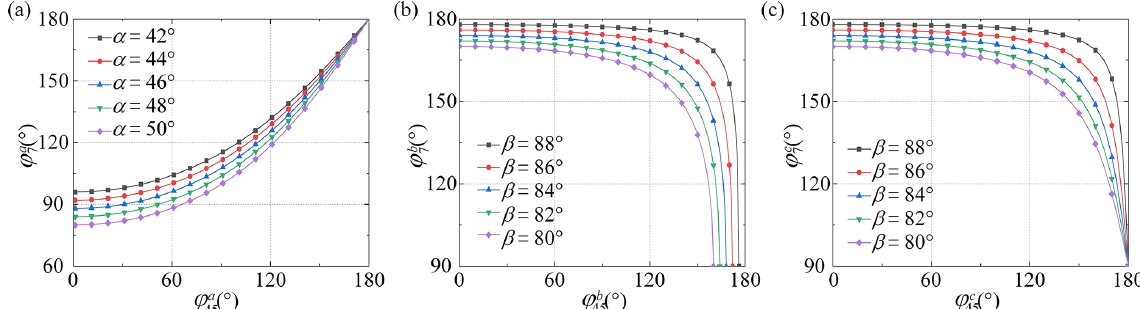
and ϕ a in U M -A; (b) the relationship between ϕ b 7 45 and ϕ c represent the angle between two RPs and two IPs 45 45